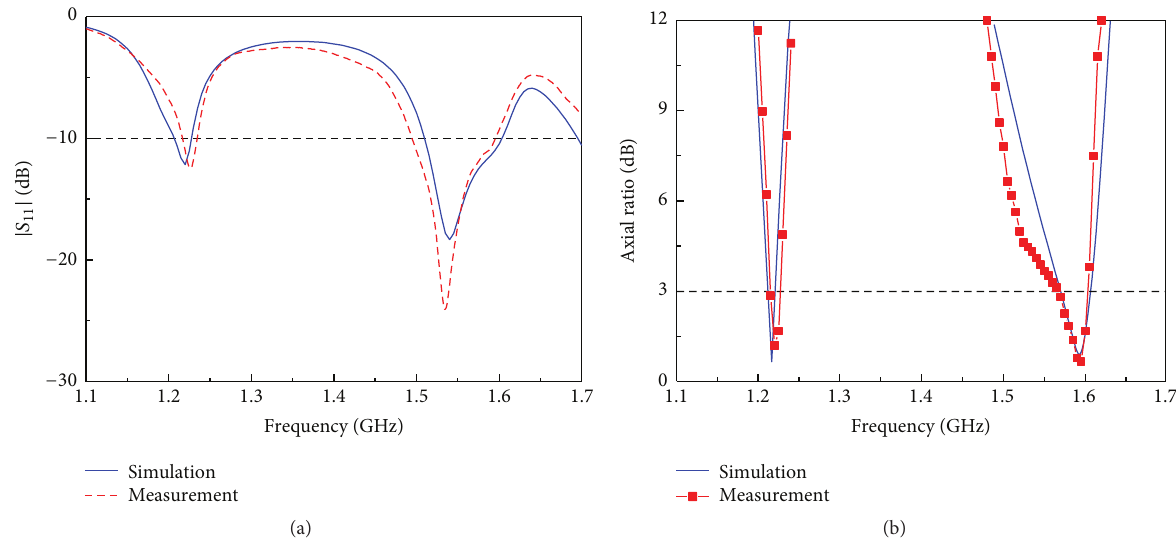
Figure 11: Measured and simulated (a) |𝑆 11 | and (b) AR values of the fabricated